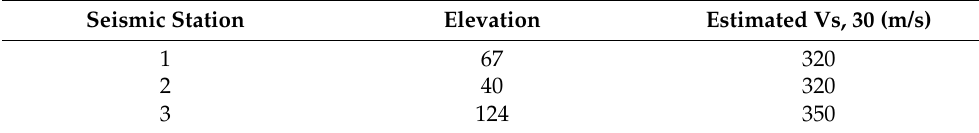
Table 4. Elevations and estimated soil Vs, 30 for the three seismic stations in Iasi